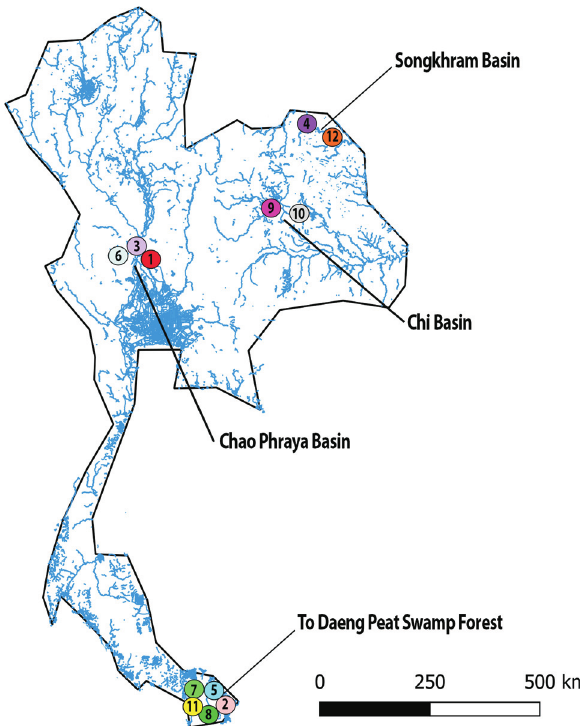
Figure 1 - Map of Thailand highlighting the collection sites of Silurid fishes studied herein. The numbers represent the different species sampled asshownin Table1. ThemapwasproducedusingthesoftwareQGis3.4.4 (https://qgis.org), Inkscape 0.92 (https://inkscape.org), and Adobe Photoshop CC 2015 (San Jose, CA,